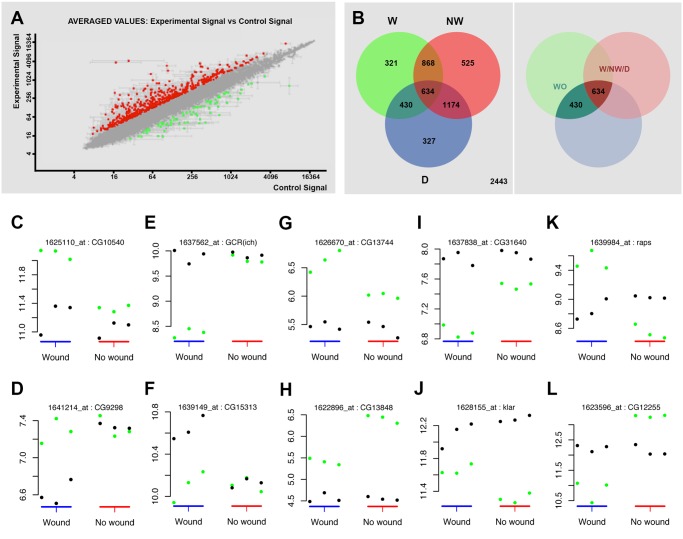
Transcriptomic healing response in imaginal discs.
A) log-log scatter plot of the averaged microarray data for the global comparison between JNK signaling positive healing-engaged cells and their siblings in wounded imaginal discs (733 upregulated (red) and 748 downregulated (green) genes—FC 1.5, p-value < 0.05). B) A Venn diagram was used to represent the interactions of the different identified populations. The W subpopulation corresponds to those 2253 genes whose expression is modified in wounded discs. The NW subpopulation corresponds to those 3201 genes whose expression is modified in non-wounded discs. The D subpopulation corresponds to those 2565 genes in wounded or non-wounded discs that appear differentially modified between JNK-positive and negative cells. The WO and W/NW/D intersections highlighted on the right covers the 430 genes differentially expressed in wounded discs only and the 634 genes differentially expressed in both, wounded and in non-wounded discs but distinctly in both conditions. C to L) Representative genes for different subpopulations covering the WO and W/NW/D sets. Green spots show the level of expression for each replica in JNK-positive cells. Black spots show the levels of expression for each replica in JNK-negative cells. C) Genes upregulated in JNK-positive cells in wounded discs only (CG10540). D) Genes downregulated in JNK-negative cells in wounded discs only (CG9298). E) Genes downregulated in JNK-positive cells in wounded discs only [GCR(ich)—CG5812]. F) Genes upregulated in JNK-negative cells in wounded discs only (CG15313). G) Genes more upregulated in JNK-positive cells in wounded than in non-wounded discs (CG13744). H) Genes less upregulated in JNK-positive cells in wounded than in non-wounded discs (CG13848). I) Genes more downregulated in JNK-positive cells in wounded than in non-wounded discs (CG31640). J) Genes less downregulated in JNK-positive cells in wounded than in non-wounded discs (klar—CG17046). K) Genes upregulated in JNK-positive cells in wounded and downregulated in non-wounded discs (raps—CG5692). L) Genes downregulated in JNK-positive cells in wounded and upregulated in non-wounded discs (CG12255).